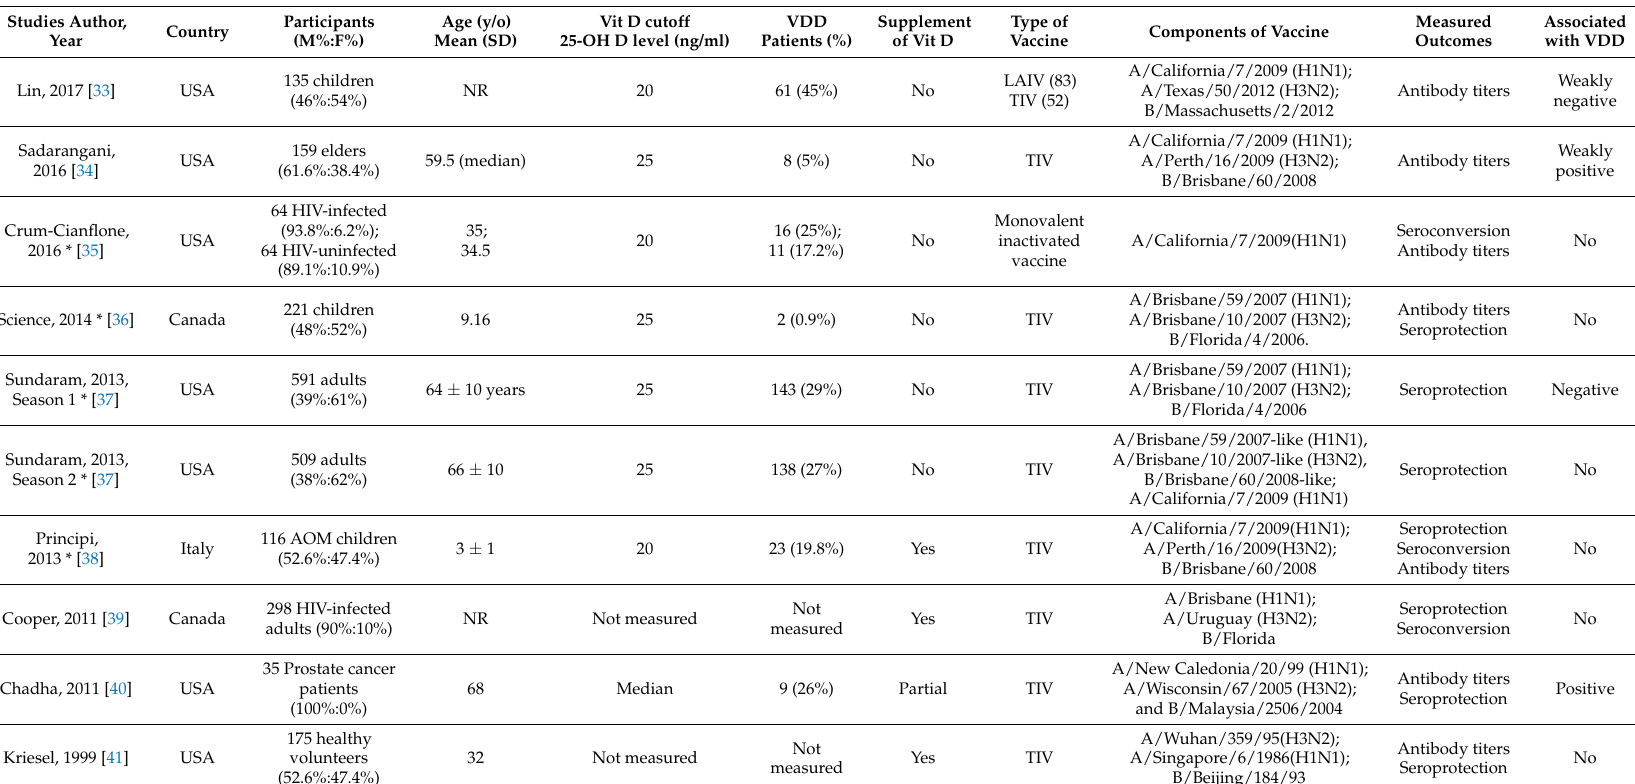
Table 1. Characteristics of randomized controlled trials investigating vitamin D and influenza